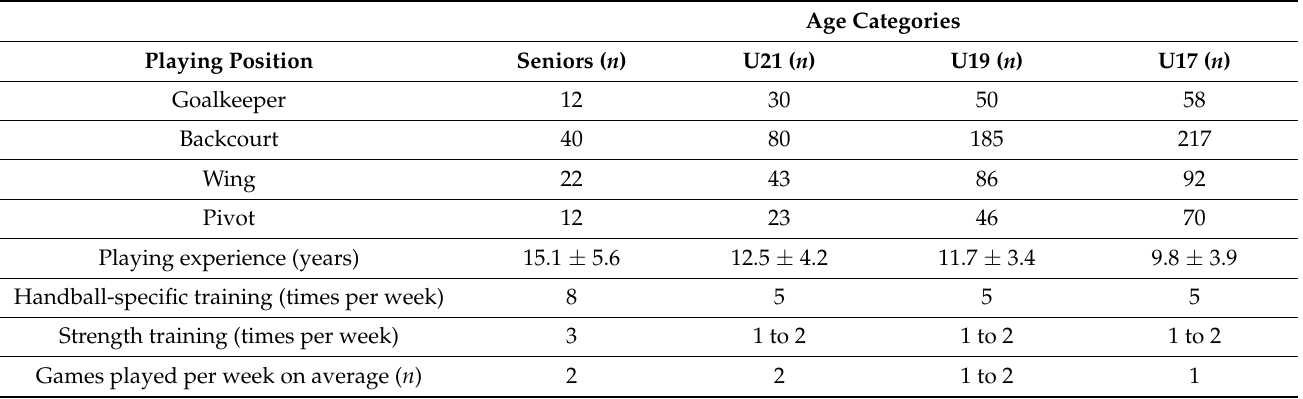
Table 1. The number of recruited handball players based on age category and playing position and their basic training